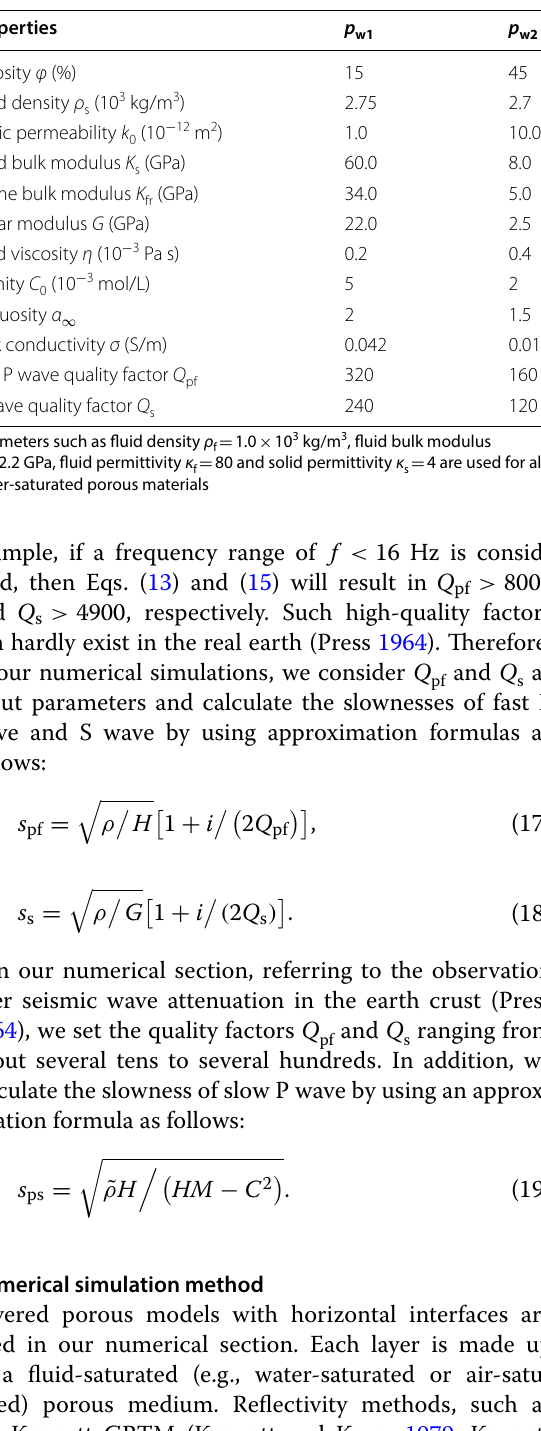
Table 1 Properties of the used water-saturated porous